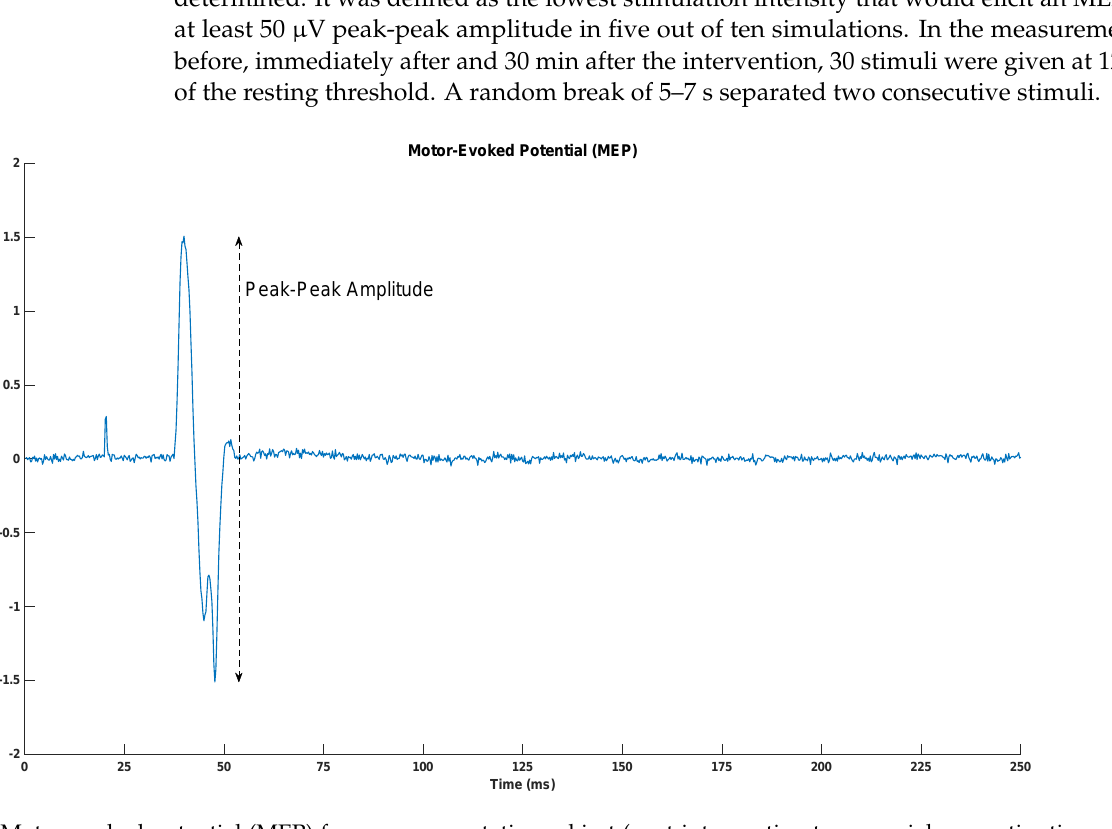
Figure 2. Motor-evoked potential (MEP) from a representative subject (post-intervention transcranial magnetic stimu- lation measurement for subject 1). The peak around 25 milliseconds is the stimulation artefact from the transcranial magnetic